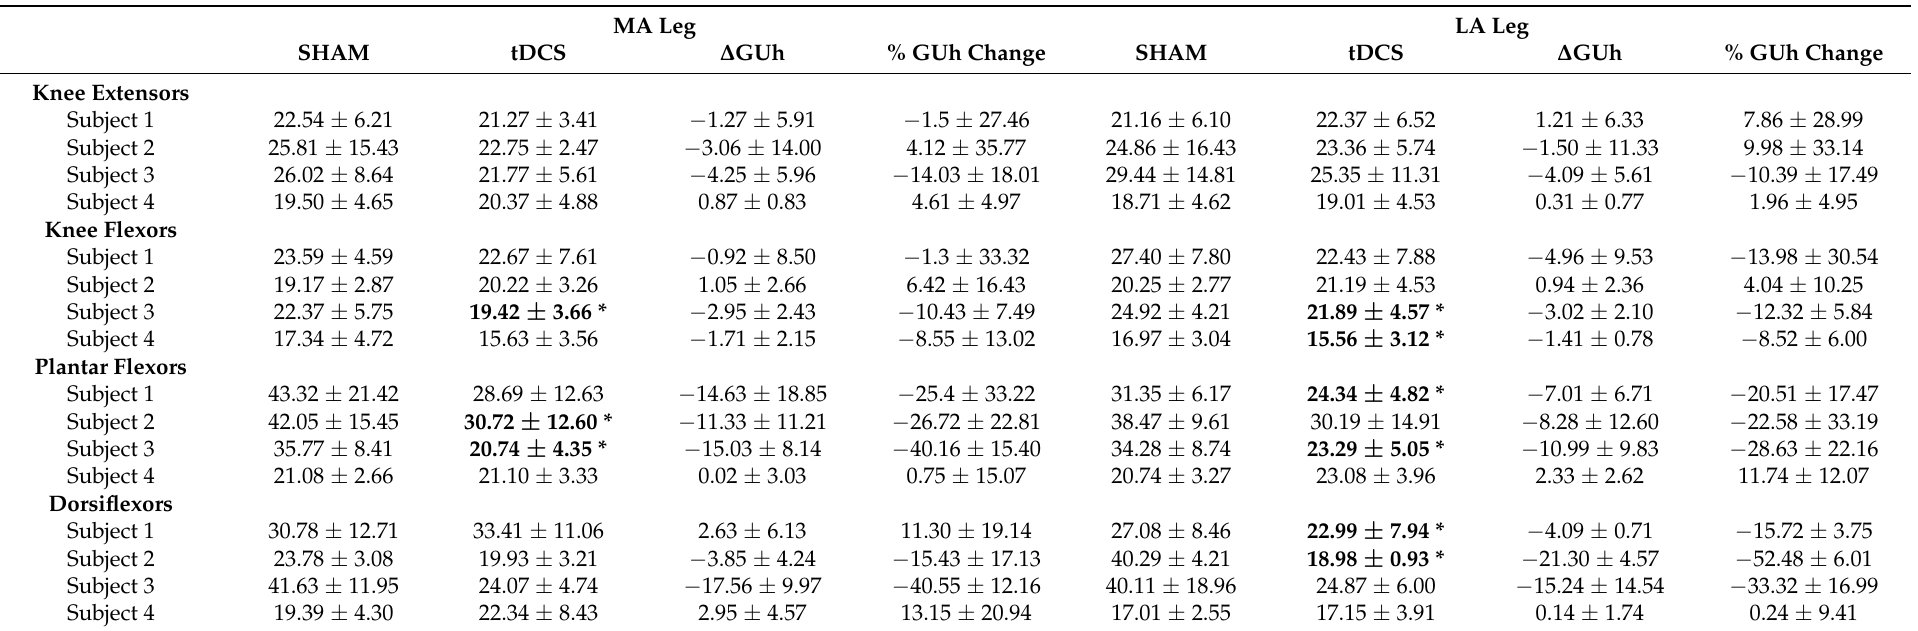
* Indicates a significant decrease in GUh after tDCS. Significance was accepted at p <